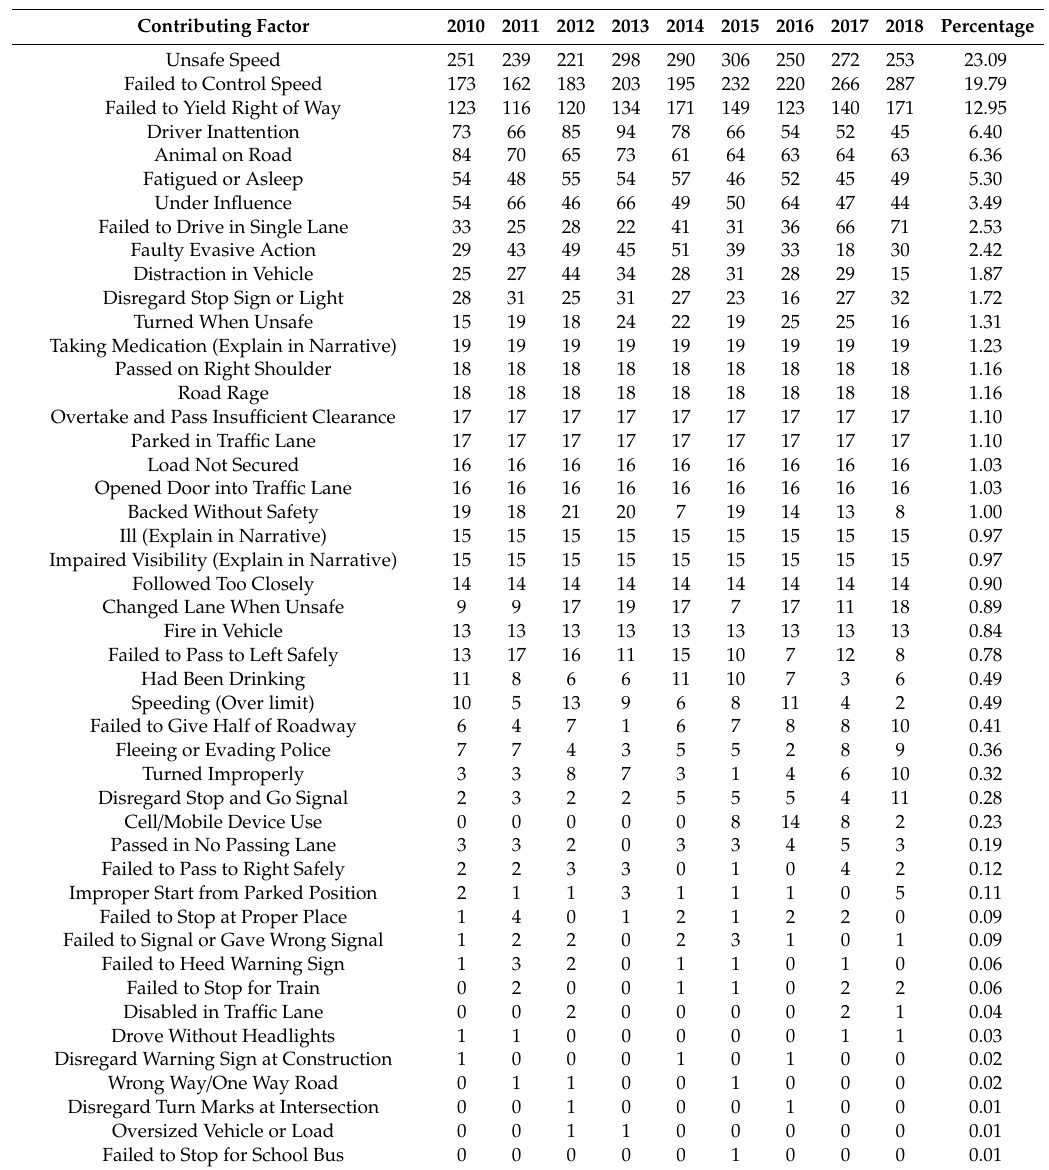
Table A2. Yearly number and causes of teen driver crashes in West Texas rural areas. Contributing